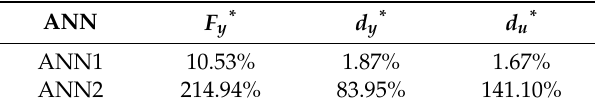
Table 4. Maximum percentage of error obtained for the TS1.